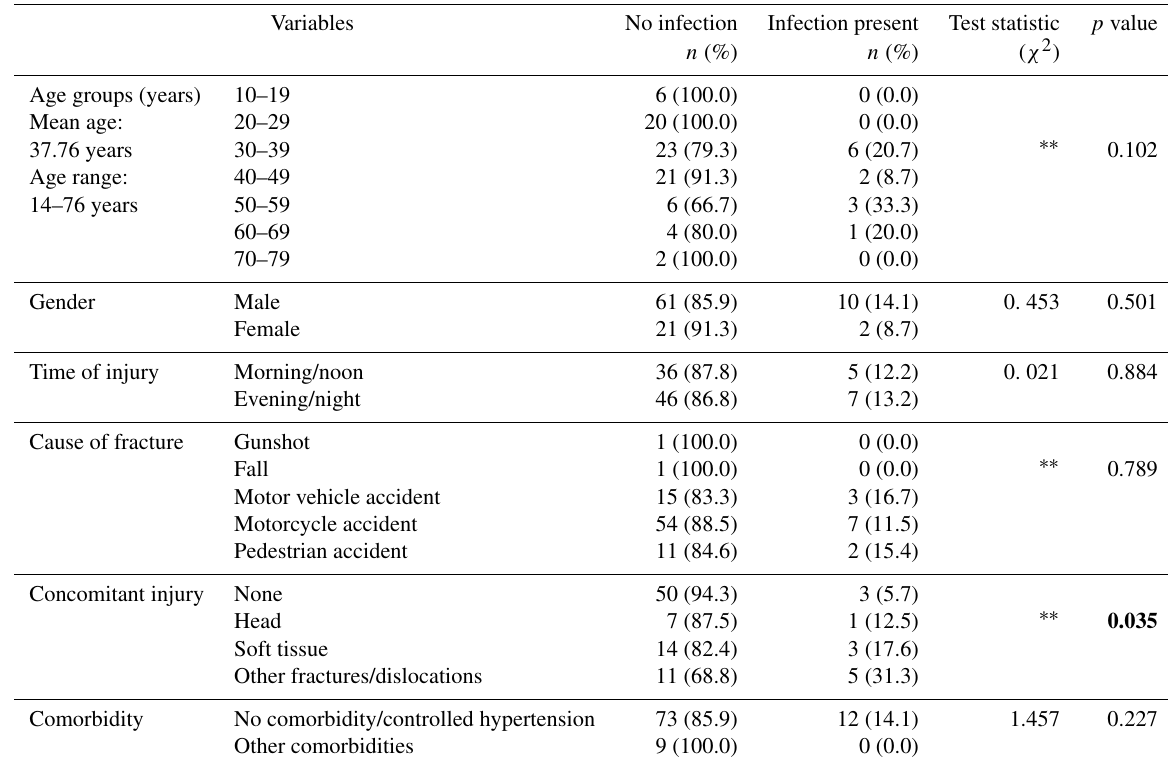
Table 1. Cross-tabulation of patient- or injury-related factors and infection ( N = 94).